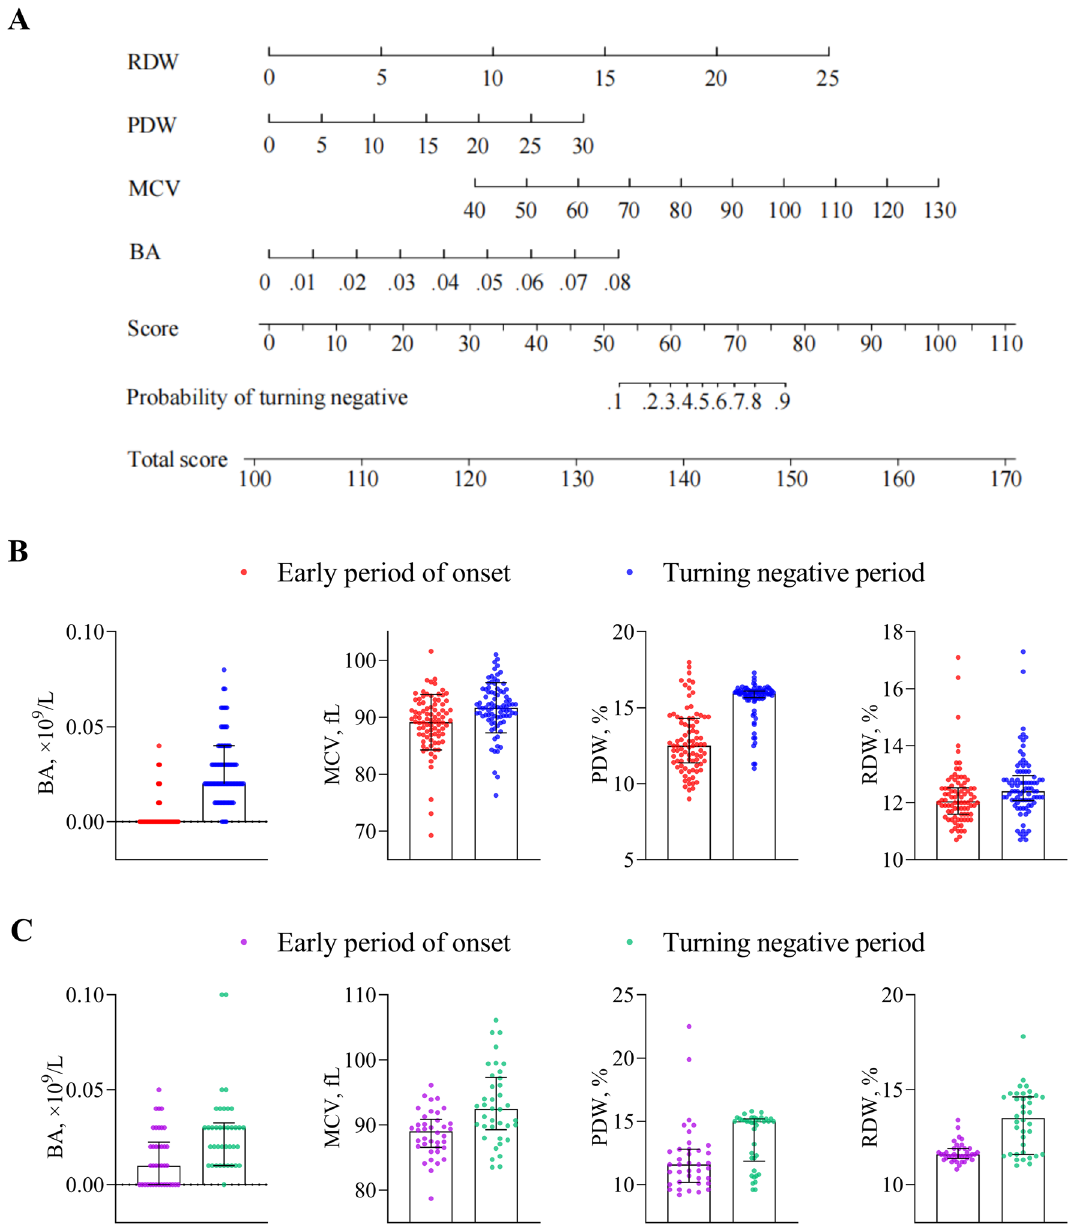
Figure 4. Visual representation of the model. ( A ) Nomogram to illustrate how BA, MCV, RDW, PDW are related to recovery. ( B ) Distribution of BA, MCV, RDW, and PDW in training cohort. ( C ) Distribution of BA, MCV, RDW, and PDW in verification